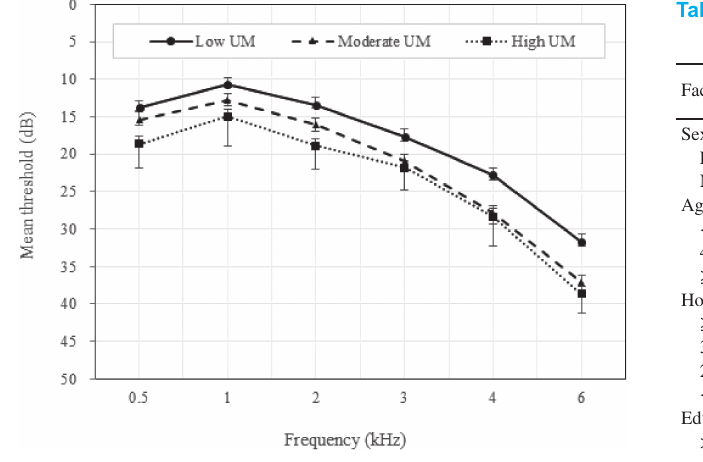
Figure 1. Mean pure-tone threshold values according to the unilateral mastication (UM) level Table 3. Adjusted odd ratios (aORs) and 95% con fi dence intervals (CIs) for hearing loss according to unilateral